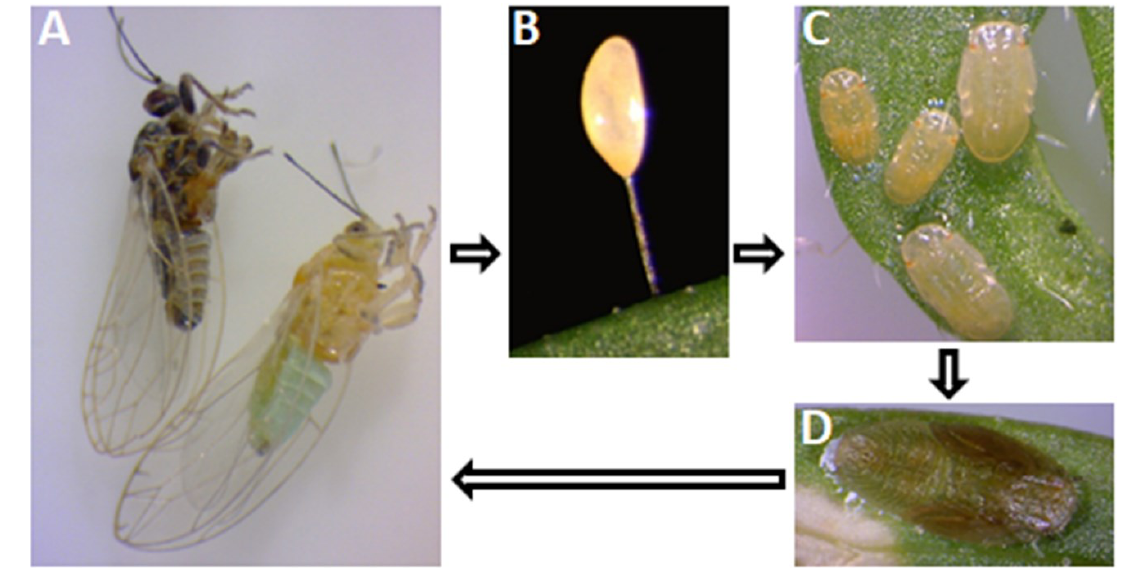
after 24 h AAP. The proportion of the CLas-positive psyllid population declined to 50% at 20 d post-acquisition.